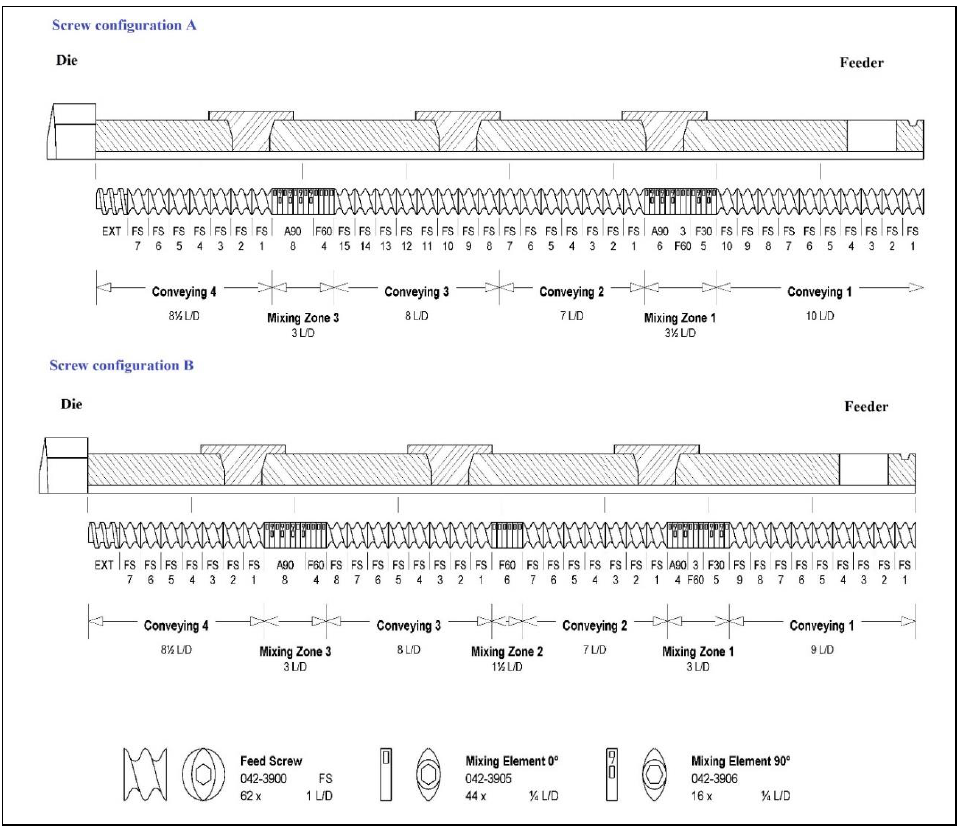
Figure 3. Schematic diagram of the screw configurations (generated with twin-screw configurator, version: 1.30 (8)).